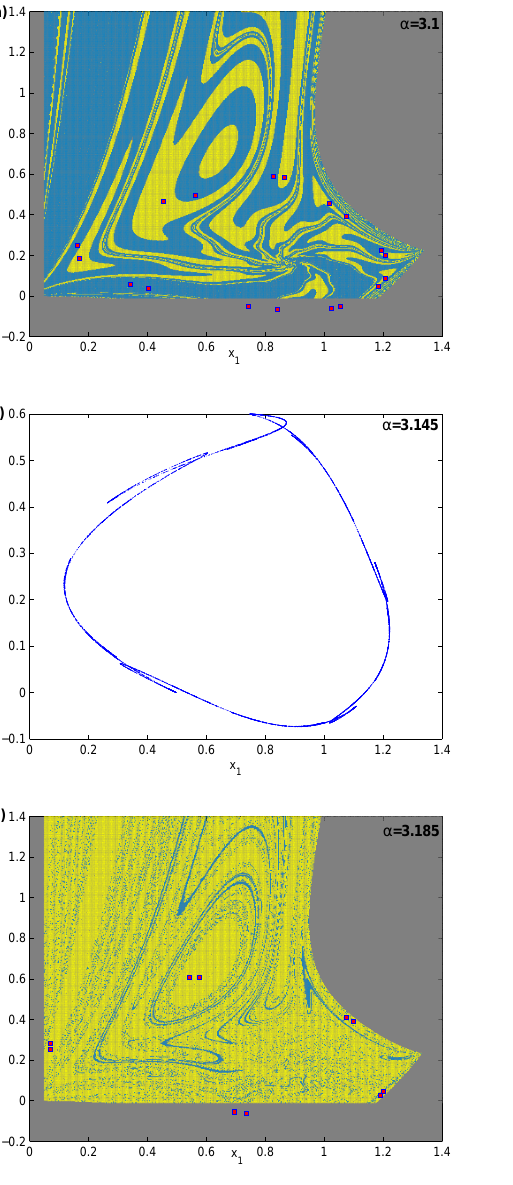
Figure 3. ( a ) Basins of attraction of period 18-cycle; ( b ) Phase space of 9-piece chaotic attractor; ( c ) Phase space of one piece chaotic attractor; ( d ) Basins of attraction of period 5-cycle; ( e ) Basins of attraction of period 10-cycle; ( f ) Some chaotic behaviors for the map. Other parameters values are c 1 = 0.15, c 2 = 0.9, ω = 0.5 and β =